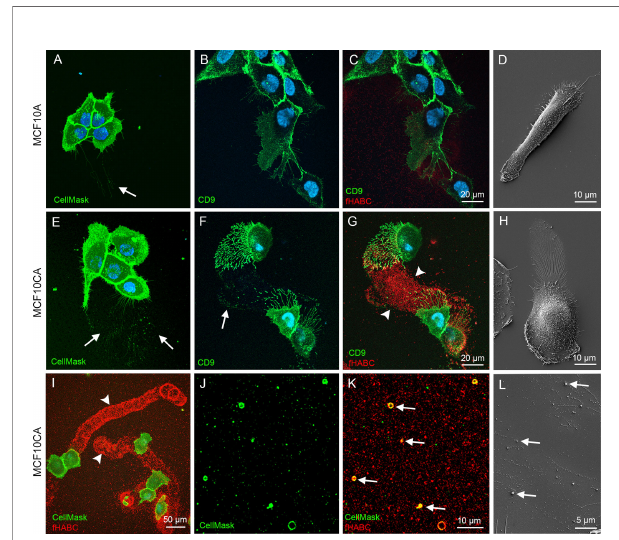
FIGURE 3 | MCF10CA cells form hyaluronan-rich trails that contain plasma membrane-derived vesicles. Live MCF10 cells stained with CellMask ® to label lipid membranes (A, E) and FITC-conjugated antibody against EV marker CD9 (B, F) co-stained with fHABC to visualize hyaluronan (C, G) . A lower- magni fi cation image (G) of double-staining with CellMask and fHABC shows the trails of up to several hundreds of micrometers long coated with hyaluronan. Scanning electron microscopic images of MCF10A (D) and MCF10CA (H) . Panel (I) shows a lower magni fi cation overview of trails of MCF10CA cells. A higher-magni fi cation images of the trail-areas show HA-coated (red) EVs (green) of different diameter (J, K) . A higher magni fi cation scanning electron microscopic image from the trail area (L) . Arrows in all panels point membrane- derived vesicles and arrowheads show hyaluronan-rich